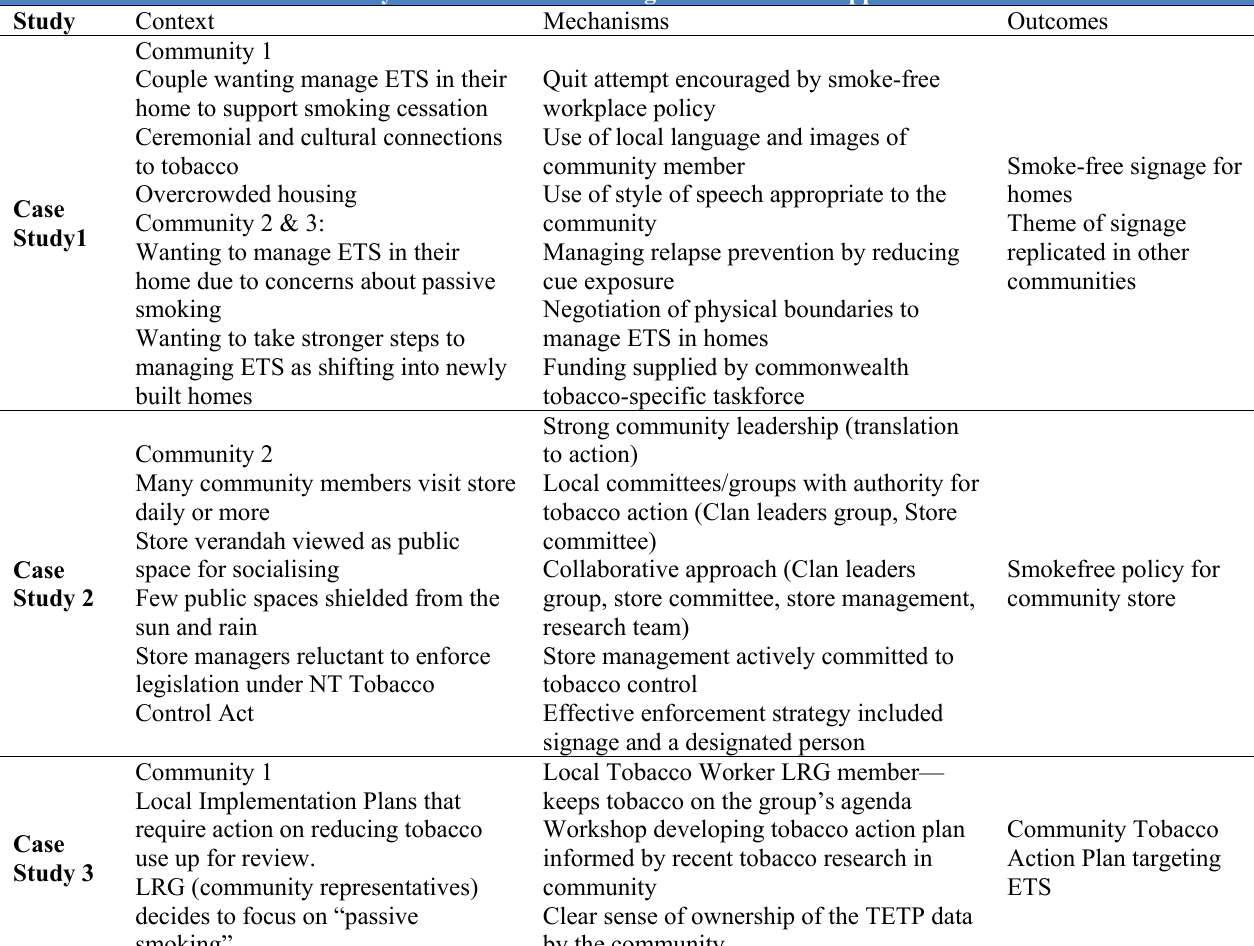
Table 3. Analysis of three case studies using a critical realist approach to explore their context, mechanisms and